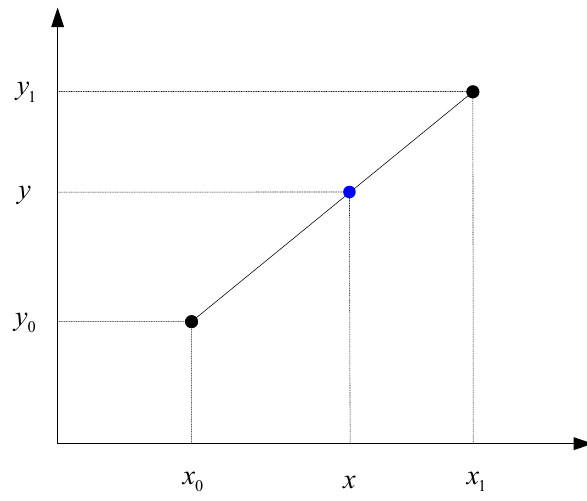
Figure 4. Diagram of linear interpolation.